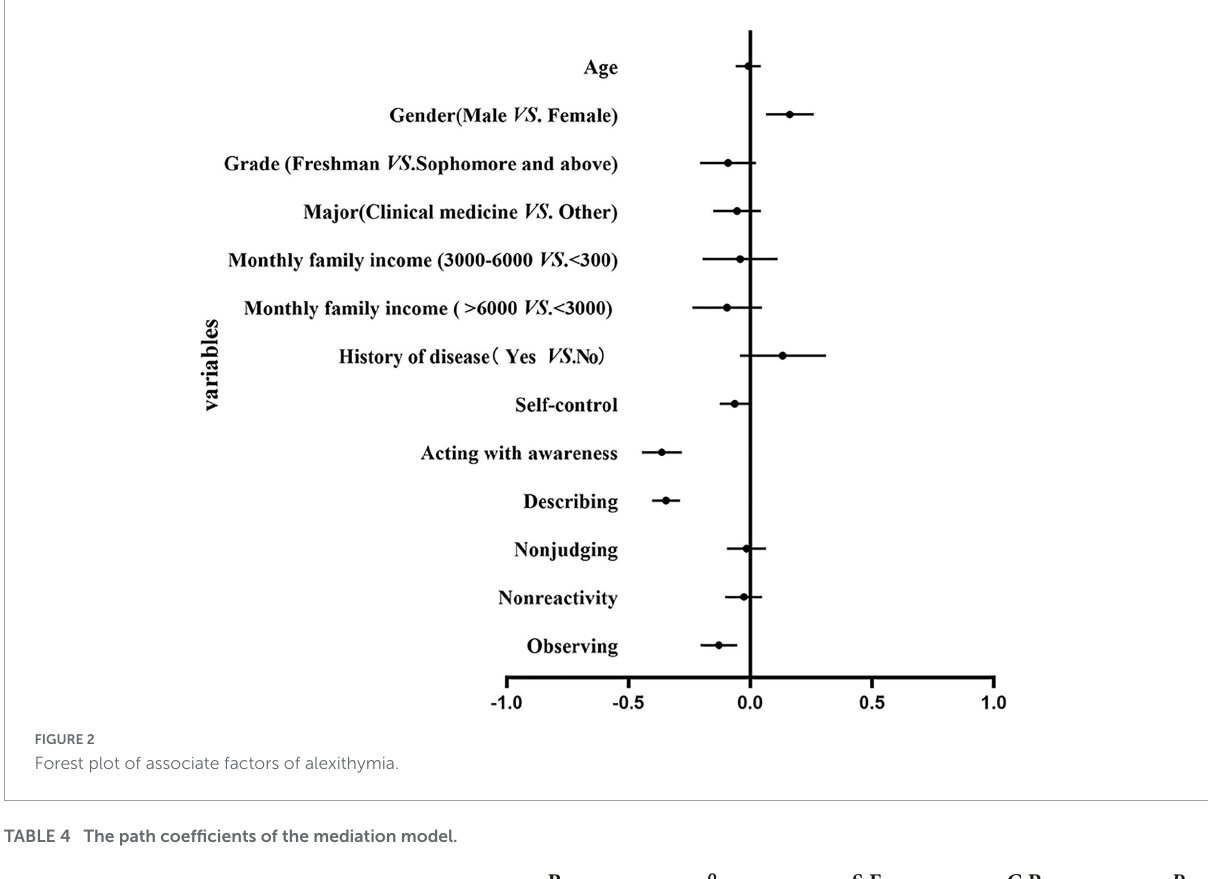
TABLE 4 The path coefficients of the mediation model.